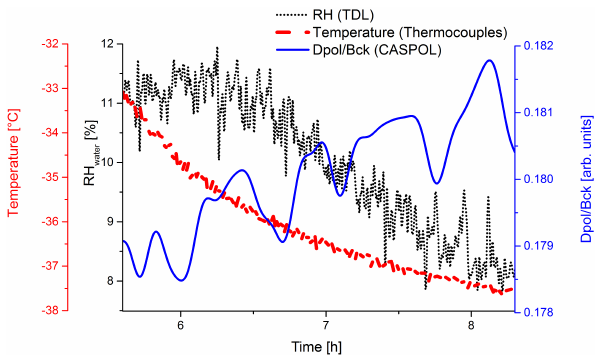
Figure 7. CASPOL filtered polarization ratio (blue line) increases as RH (black dotted line) decreases during the cooling period after a SOA experiment (Run no.